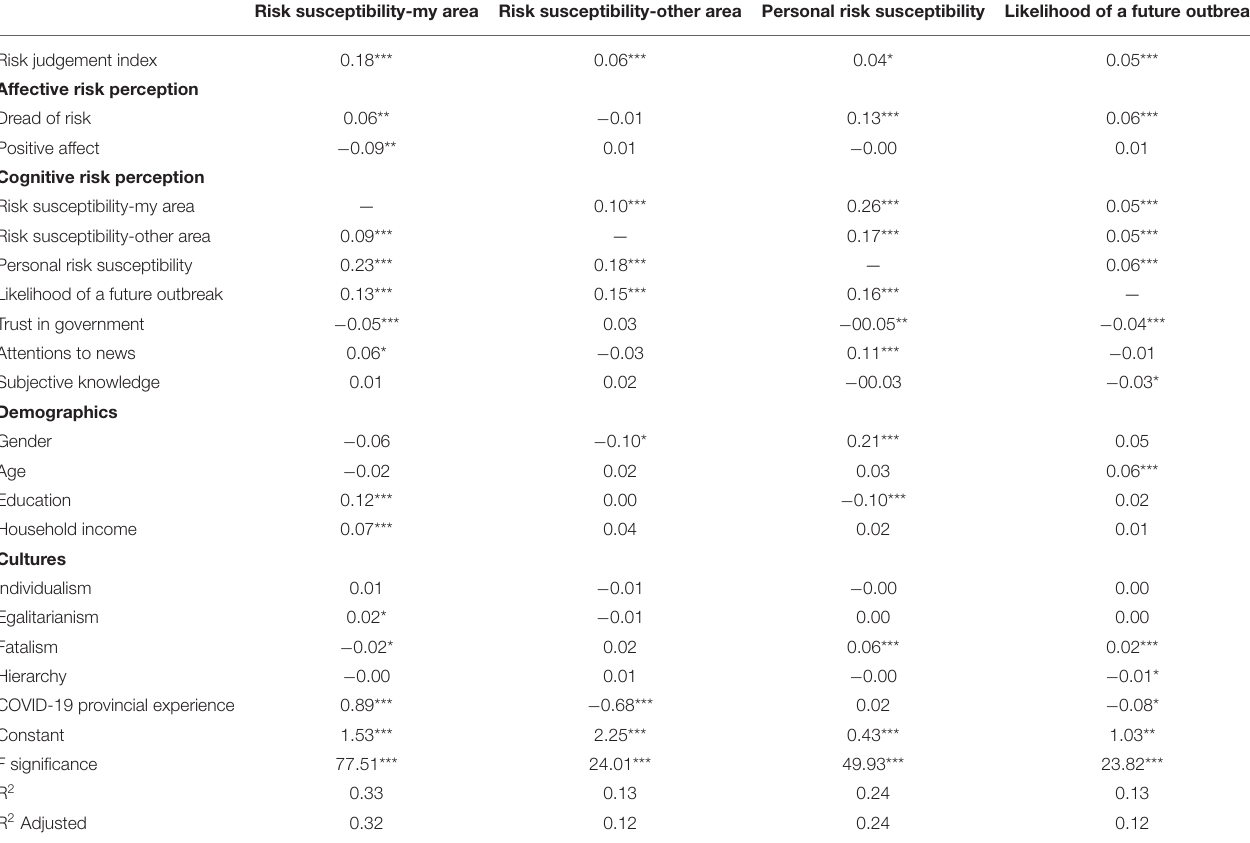
TABLE 4 | Linear regressions of cognitive risk perception and survey of public reactions to COVID-19, China,